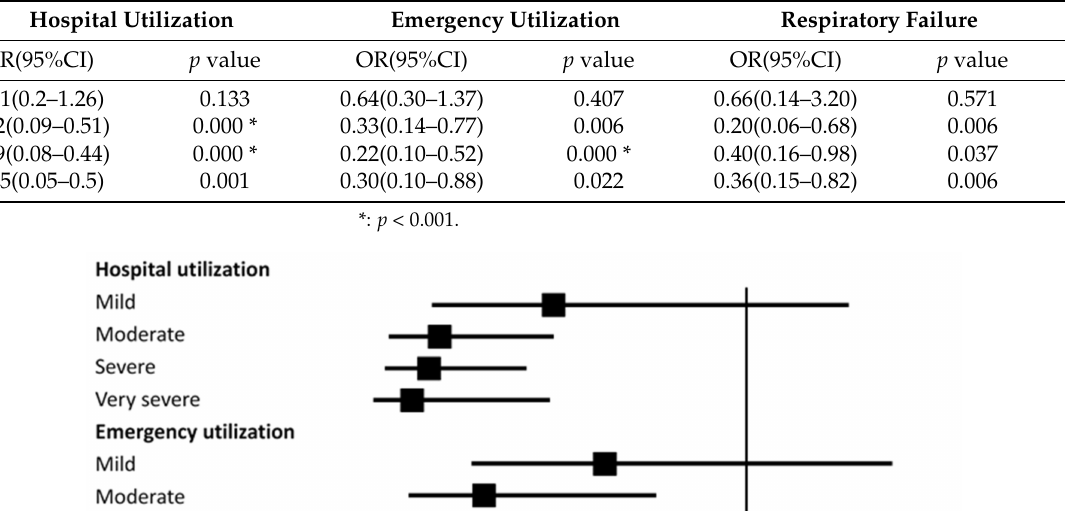
Table 3. Adjusted odds ratio of the likelihood of medical utilization according to influenza vaccination status among COPD patients with different severities of airflow obstruction.